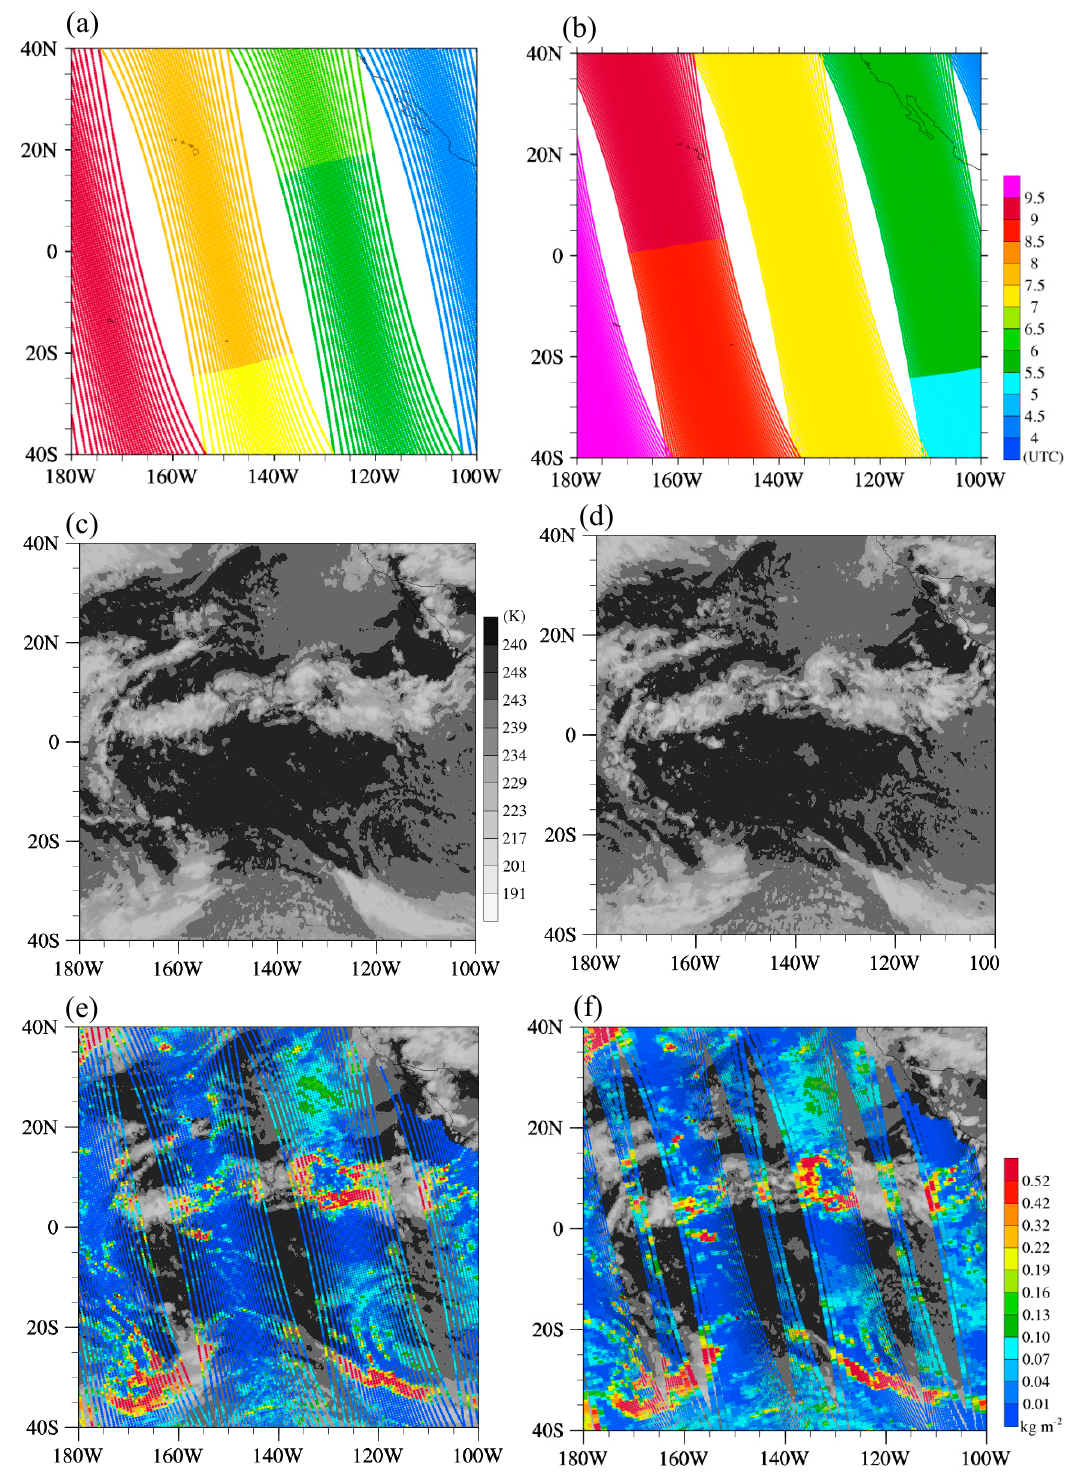
Figure 13. ( a ) MetOp-B AMSU-A and ( b ) FY-3C MWTS-2 data times in UTC, ( c , d ) GOES-15 10.7 µ m imagery brightness temperature observations (unit: K) at (c) 0600 UTC and (d) 0900 UTC, and ( e , f ) liquid water path (colored dots) at (e) AMSU-A and (f) MWTS-2 observing locations over oceans at ascending nodes on 15 July 2014.